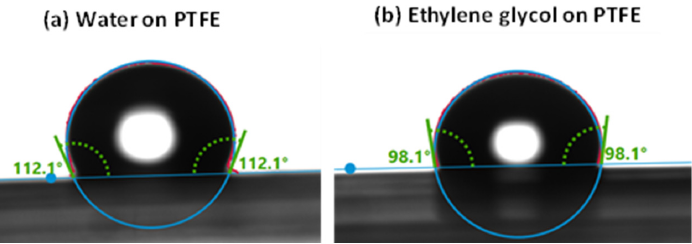
Figure 1. Dynamic contact angles at the interfaces of a moving droplet for ( a ) water on PTFE and ( b ) ethylene glycol on